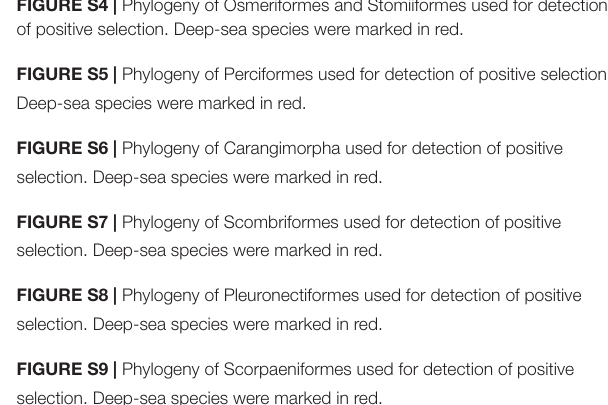
FIGURE S1 | Phylogeny of Anguilliformes used for the detection of positive selection. Deep-sea species were marked in red. FIGURE S2 | Phylogeny of Beryciformes and Stephanoberyciformes used for detection of positive selection. Deep-sea species were marked in red. FIGURE S3 | Phylogeny of Ophidiiformes used for detection of positive selection. Deep-sea species were marked in red. FIGURE S4 | Phylogeny of Osmeriformes and Stomiiformes used for detection of positive selection. Deep-sea species were marked in red. FIGURE S5 | Phylogeny of Perciformes used for detection of positive selection. Deep-sea species were marked in red. FIGURE S6 | Phylogeny of Carangimorpha used for detection of positive selection. Deep-sea species were marked in red. FIGURE S7 | Phylogeny of Scombriformes used for detection of positive selection. Deep-sea species were marked in red. FIGURE S8 | Phylogeny of Pleuronectiformes used for detection of positive selection. Deep-sea species were marked in red. FIGURE S9 | Phylogeny of Scorpaeniformes used for detection of positive selection. Deep-sea species were marked in red. FIGURE S10 | Three-dimensional representation of convergent/parallel amino acid sites in deep-sea fishes in the NADH-ubiquinone oxidoreductase chain 1, 2, 3, 4, 4L, 5 and 6. Convergent/parallel amino acid sites within NADH subunits are mapped to the bovine ND structure [PDB:5LDX]. Parallel amino acid sites S250A and L251F occur in ND1; Parallel amino acid sites F21L, L154I, T229S and T310I and convergent amino acid sites A/M261I and T/P322I occur in ND2. ND3 has one parallel amino acid site V94I. Parallel amino acid sites A20T, I96L, G111S and I442V occur in ND4 and parallel amino acid site L94M is in ND6. Red indicates mutations located in intracellular domain, TM subunit sites are in black, and blue shows extracellular domain sites. MM: mitochondrial matrix; IM: intermembrane space. FIGURE S11 | Three-dimensional representation of parallel amino acid sites in deep- sea fishes in cytochrome c oxidase subunits I, II and III. Ten parallel amino acid sites map to the bovine COX structure [PDB:1V54]. Sites M92I, I97M, V155I, V416I and V460I occur in COX1, sites S47T, I97V, M100I and S155T are in COX2, and site T119A is in COX3. Mutation sites located in the intracellular domain are shown in red while TM subunit sites are shown in black. MM: mitochondria matrix; IM: intermembrane space. TABlE S1 | The depth-range of 115 species of 1,042 bony fishes. TABlE S2 | Selective pressure analyses for the 13 genes in Anguilliformes. TABlE S3 | Selective pressure analyses for the 13 genes in Beryciformes and Stephanoberyciformes. TABlE S4 | Selective pressure analyses for the 13 genes in Ophidiiformes. TABlE S5 | Selective pressure analyses for the 13 genes in Osmeriformes and Stomiiformes. TABlE S6 | Selective pressure analyses for the 13 genes in Perciformes. TABlE S7 | Selective pressure analyses for the 13 genes in Carangimorpha. TABlE S8 | Selective pressure analyses for the 13 genes in Scombriformes. TABlE S9 | Selective pressure analyses for the 13 genes in Pleuronectiformes. TABlE S10 | Selective pressure analyses for the 13 genes in